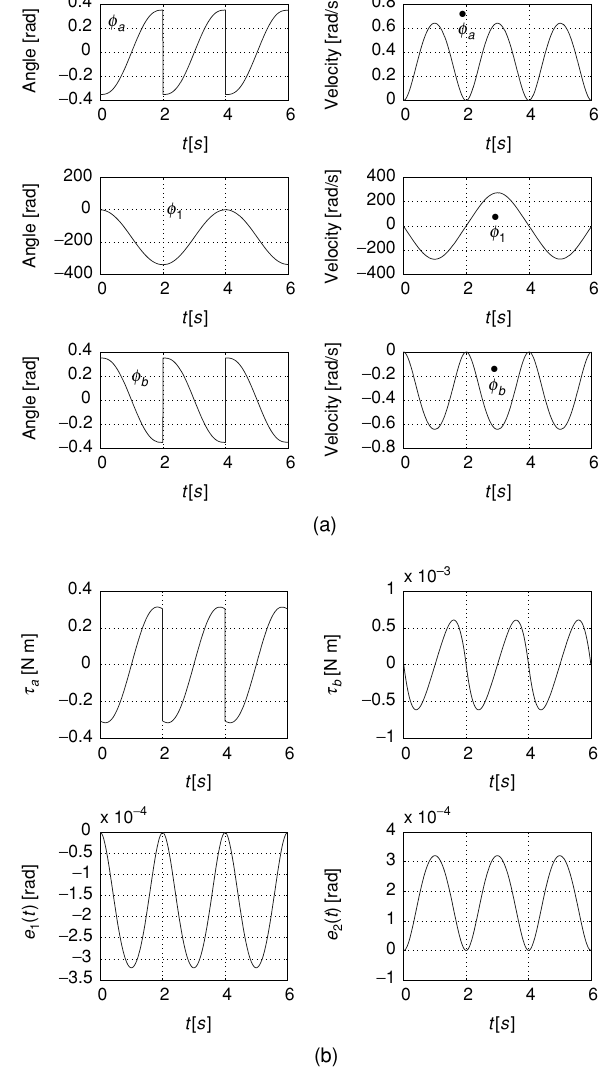
Figure 3 Simulations results for T = 6 s; three steps are carried out. (a) States of stance leg, φ a , and swing leg, φ b , and rotary body, φ 1 . Notice that φ a and φ b commute each other at each step. (b) Torques (top row) and tracking errors (bottom